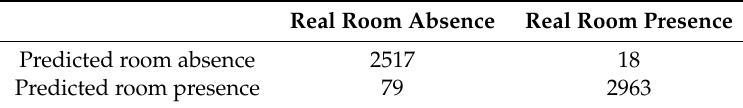
Table 7. Contingency table for the normalised classifier.